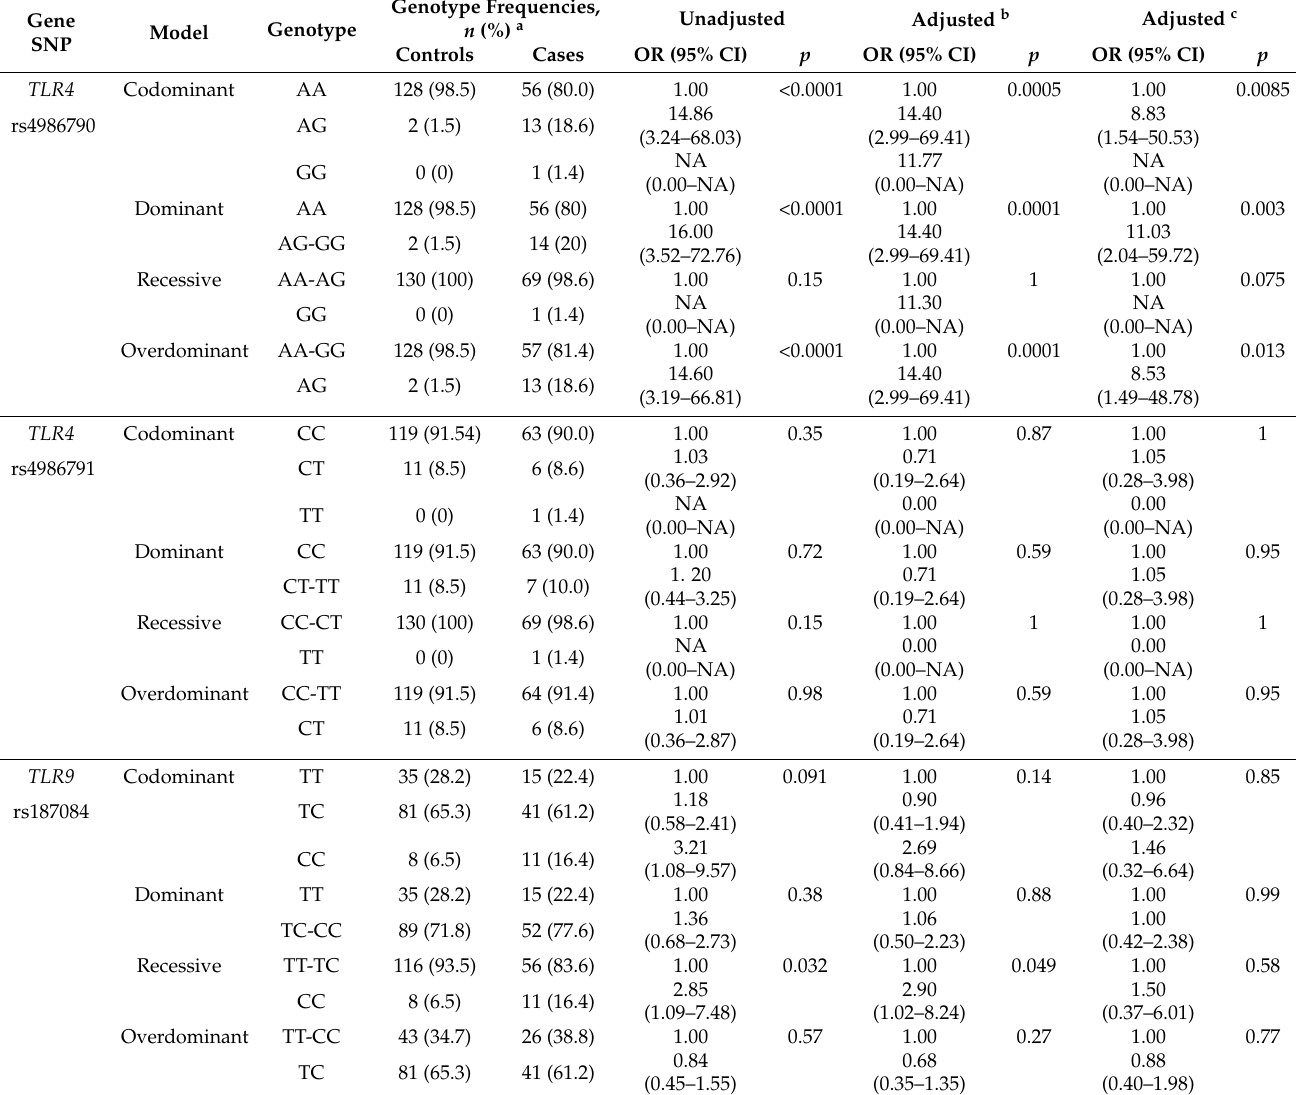
Table 1. The distribution of genotype frequencies of TLR SNPs in healthy women and those with ovarian cancer. An association of TLR genotype with the occurrence of ovarian cancer related to HPV